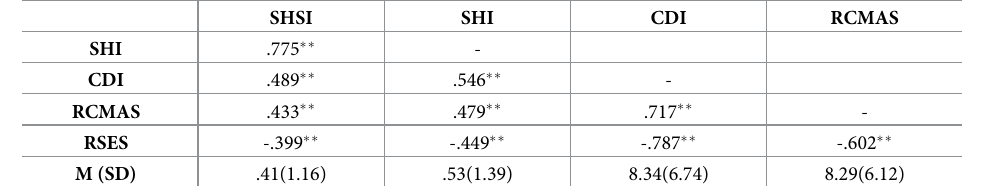
Table 7. Correlations with related measures. SHSI SHI CDI RCMAS SHI .775 �� - CDI .489 �� .546 �� - RCMAS .433 �� .479 ��